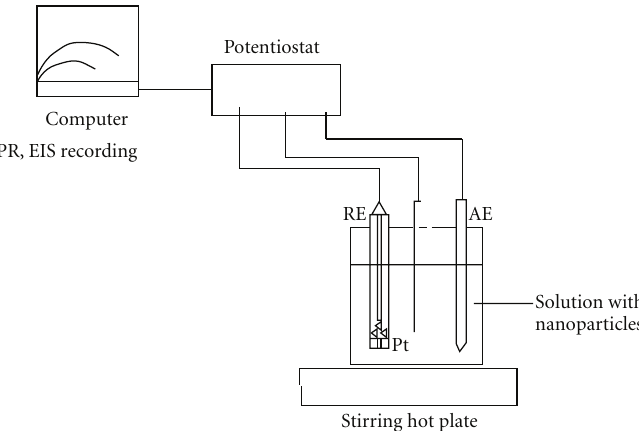
Figure 1: Electrochemical cell schematic representation used for the EIS and LPR electrochemical tests.